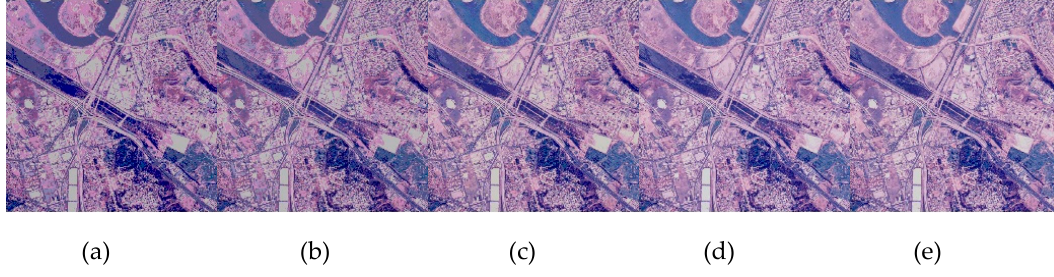
Figure 8. The segmented results of Satellite image1. ( a ) WOA; ( b ) FPA; ( c ) PSO; ( d ) BA; and ( e ) HSOA.